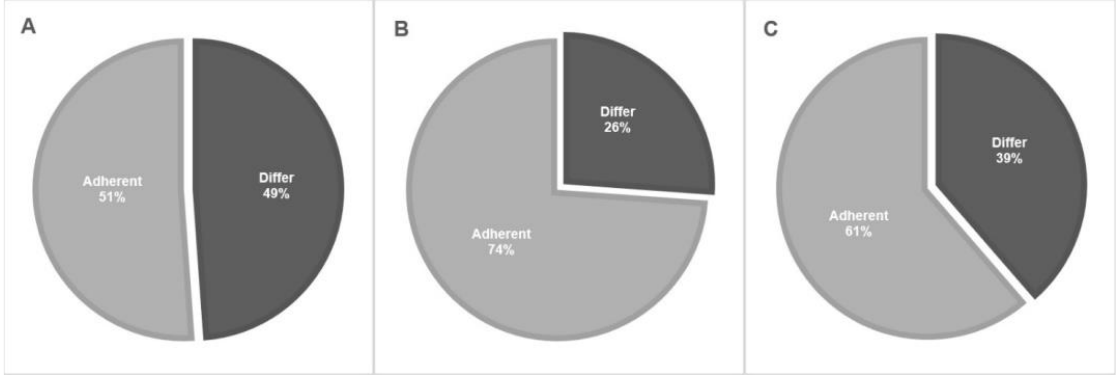
Figure 1. Adherence to EAU and NCCN guidelines on the indications for endoscopic treatment. ( A )—Total adherence rates. ( B )—Adherence to tumor grade recommendations. ( C )—Adherence to focality recommendations.